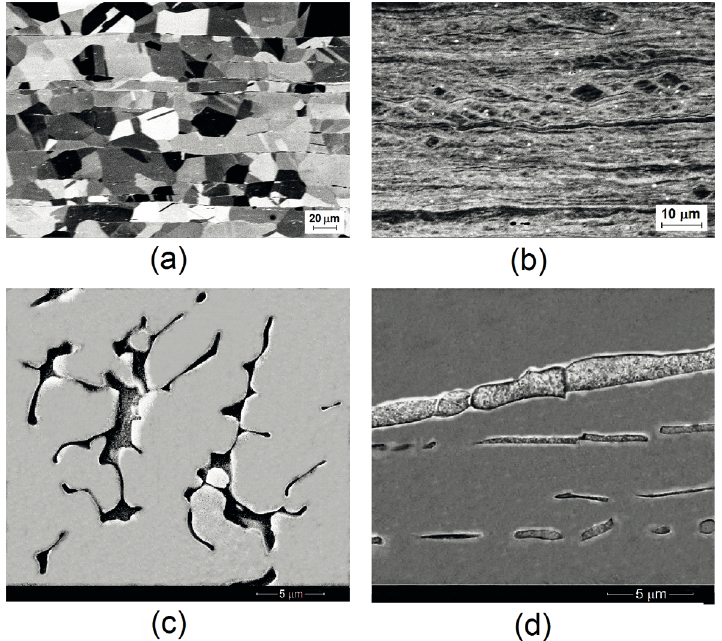
Figure 1. Microstructures of the AISI 317L specimens studied: (a) AR (as-received); (b) 87%-CR (r = 87%); (c) WM (weld metal); (d) A-450 (aged at 450 o C for 400 h).